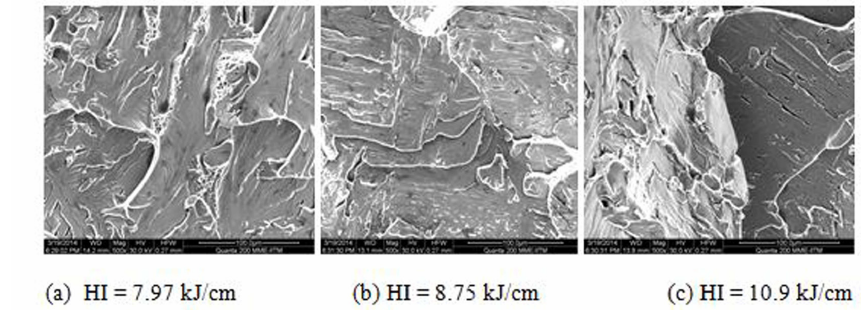
Figure 7. Fractographs of impact tested surface of weld deposit under different heat inputs